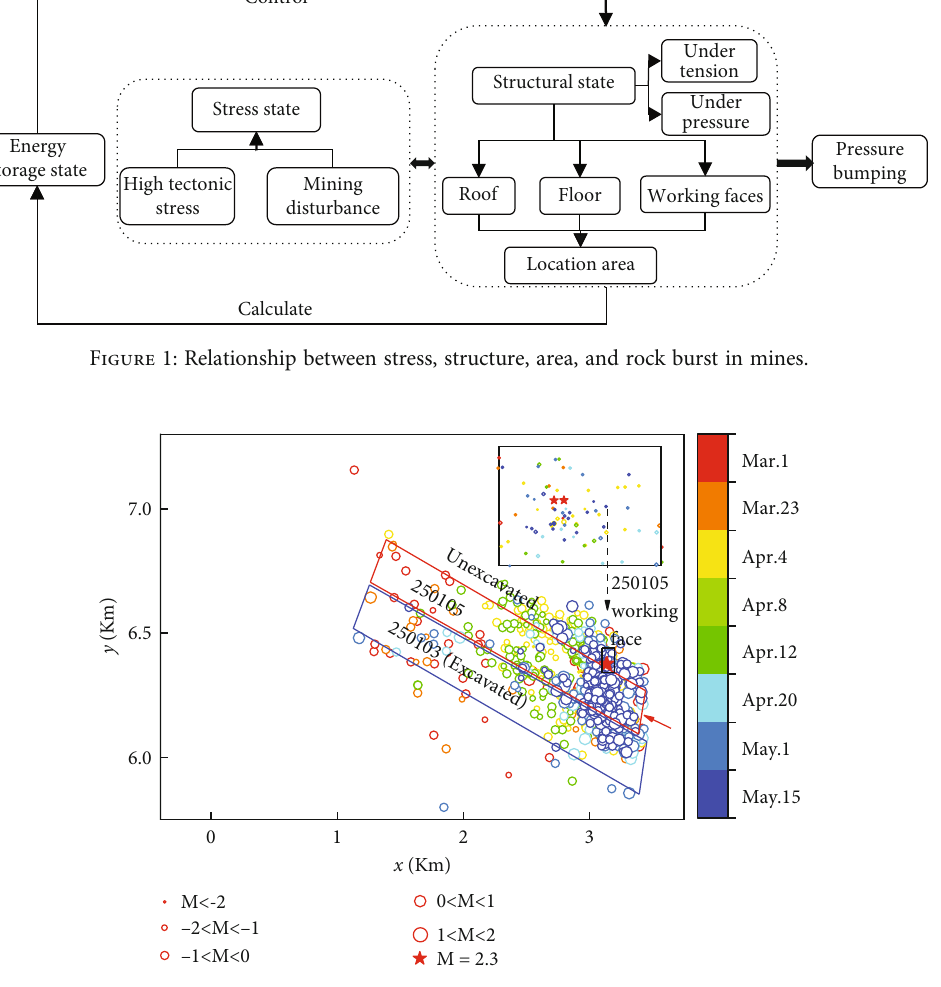
Figure 2: Projection of seismic plane